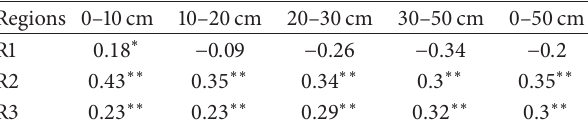
Table 1: The correlation coefficients between simulated monthly mean and measured SM of each layer over the